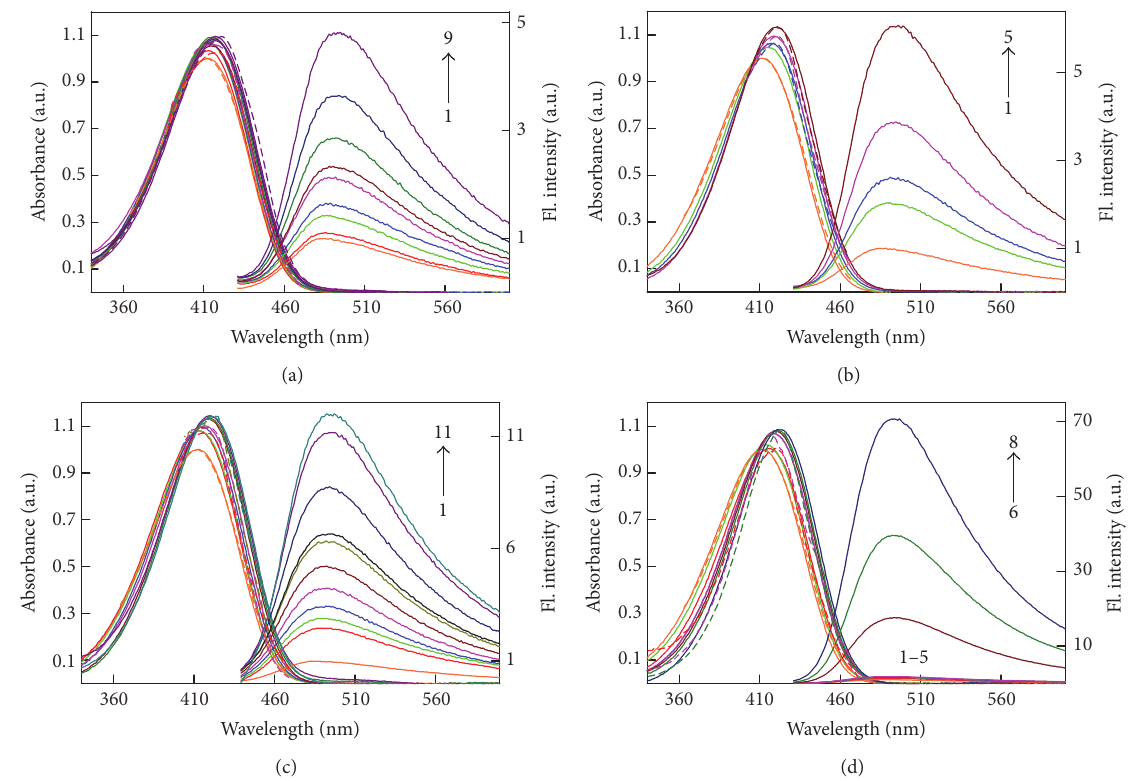
Figure 2: Absorption, fluorescence, and fluorescence excitation spectra of ThT in aqueous solutions in the presence of crowding agents and glycerol. (a) Absorption and fluorescence spectra (solid lines) of ThT in aqueous solutions in the presence of Dextran-70 in concentrations 0, 10, 50, 100, 150, 200, 250, 300, and 400 mg/mL (curves 1–9) and fluorescence excitation spectra (dashed lines) of ThT in aqueous solutions in the presence of Dextran-70 in concentrations 0, 10, 100, and 400 mg/mL (colors are similar to that of the absorption and fluorescence spectra) are presented. (b) Absorption and fluorescence spectra (solid lines) of ThT in aqueous solutions in the presence of PEG-400 in concentrations 0, 100, 200, 300, and 400 mg/mL (curves 1–5) and fluorescence excitation spectra (dashed lines) of ThT in aqueous solutions in the presence of PEG-400 in concentrations 0, 200, 300, and 400 mg/mL (colors are similar to that of the absorption and fluorescence spectra) are presented. (c) Absorption and fluorescence spectra (solid lines) of ThT in aqueous solutions in the presence of PEG-12000 in concentrations 0, 10, 20, 50, 100, 150, 200, 250, 300, 350, and 400mg/mL (curves 1–11) and fluorescence excitation spectra (dashed lines) of ThT in aqueous solutions in the presence of PEG-12000 in concentrations 0, 10, 100, and 300 mg/mL (colors are similar to that of the absorption and fluorescence spectra) are presented. (d) Absorption and fluorescence spectra (solid lines) of ThT in aqueous-glycerol solutions with glycerol content of 0, 12, 25, 46, 61, 75, 89, and 99% (curves 1–8) and fluorescence excitation spectra (dashed lines) of ThT in aqueous-glycerol solutions with glycerol content of 0, 12, 61, and 89% (colors are similar to that of the absorption and fluorescence spectra) are presented; ThT concentration was ∼ 3 ⋅ 10 −5 M. Fluorescence spectra were excited at 412 nm and recorded at 490